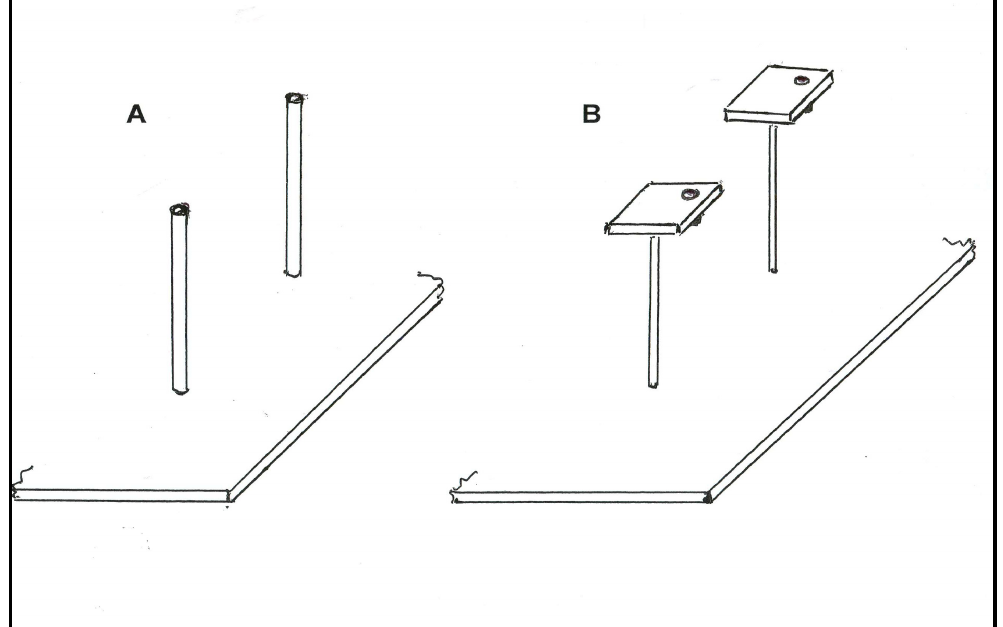
Figure 1. Flower morphologies used in experiments. Tube flowers ( A ) have a false bottom 15 mm from the top, which makes the well-depth the same as that of flat flowers. Flat flowers ( B ) have the same well opening to enter and same well depth for the reward as the tube flowers. Thus, no difference in effort needed to obtain rewards from the alternative flower morphologies existed (Panel A and B drawn by